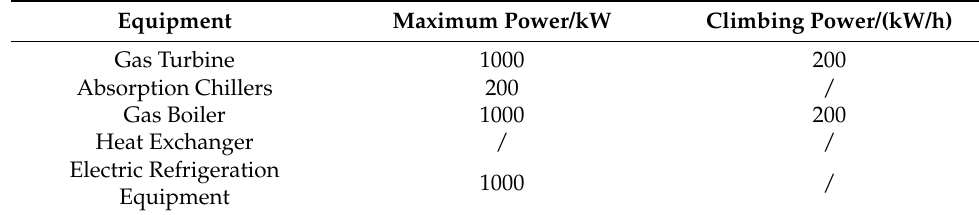
Table A1. Equipment parameters.